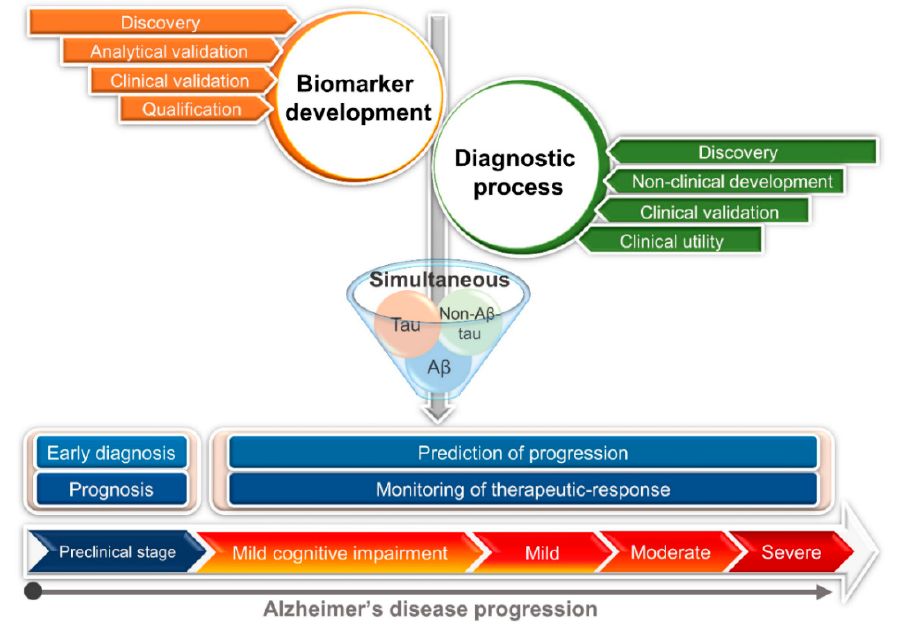
Figure 4. Future perspective for monitoring of AD at different clinical stages using nanobiosensors via the simultaneous measurement of A β , Tau and non-A β -Tau biomarkers.